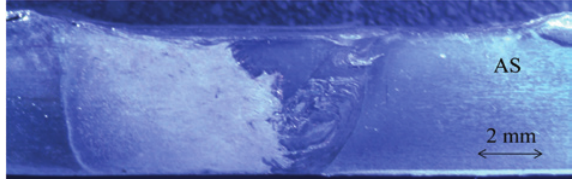
Figure 7: Macrograph with Cu as intermediate metal with interca- lated Cu layers in